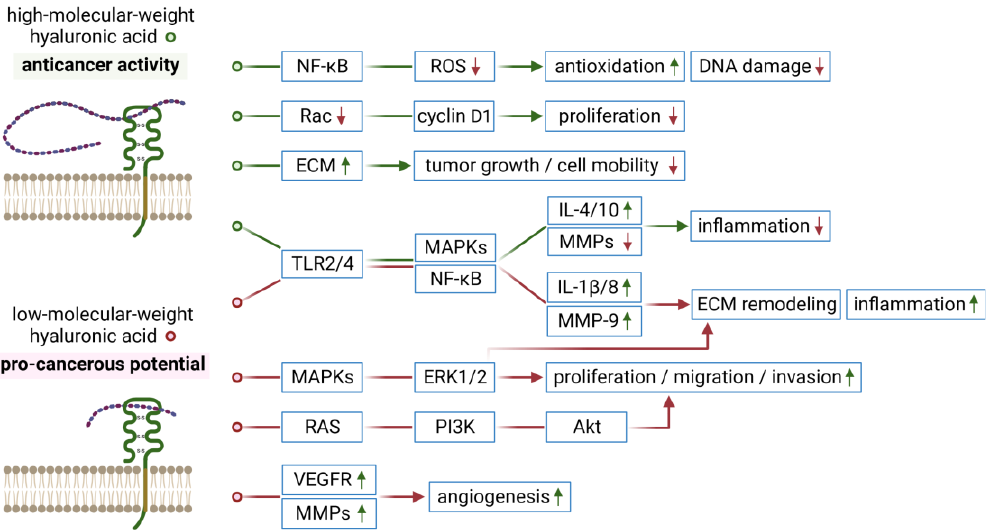
Figure 3. Summary of the anticancer activities of high-molecular-weight hyaluronic acid versus pro-cancerous potential of its degradation products (low-molecular-weight hyaluronic acid) due to triggering the signaling cascades through CD44 receptor. Abbreviations used: ECM, extracellular matrix; ERK1/2, extracellular signal‑regulated protein kinases 1 and 2; IL, interleukin; MAPKs, mitogen-activated protein kinases; MMPs, matrix metalloproteinases; NF- κB, nuclear factor κ -light-chain-enhancer of activated B cells; PI3K, phosphoinositide 3-kinase; ROS, reactive oxygen species; TLR2/4, Toll-like receptors 2 and 4; VEGFR, vascular endothelial growth factor receptor. The figure was created with BioRender.com, accessed on 28 November